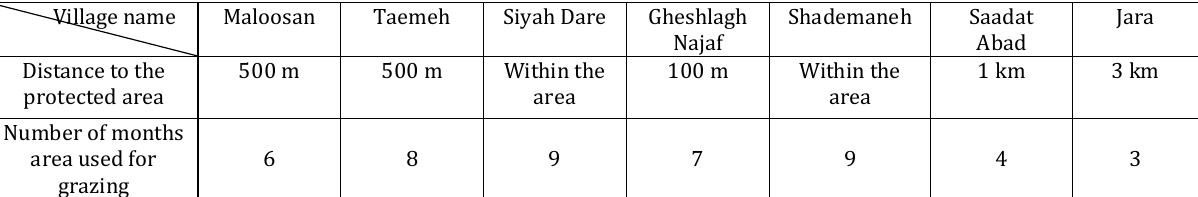
Table 2. Duration of livestock grazing in the protected area